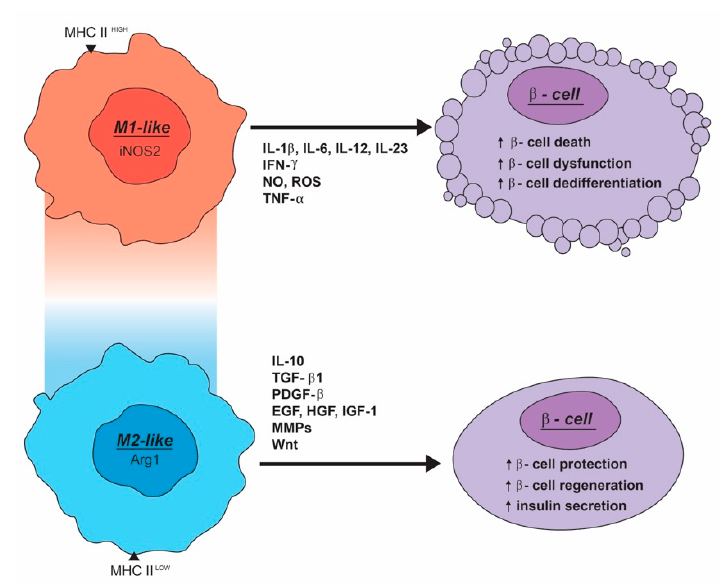
Figure 2. How the M1-like and M2-like extremes of the macrophage activation spectrum affect β -cell function, survival, and proliferation through secreted factors. M1-like macrophages are inflammatory in nature, producing and secreting inflammatory cytokines, NO, and ROS. M2-like macrophages play more of a protective role by inducing β -cell survival and proliferation. M2-like macrophages secrete anti-inflammatory cytokines, signaling peptides, and enzymes involved in tissue remodeling, inducing β -cell proliferation and enhancing insulin secretion.